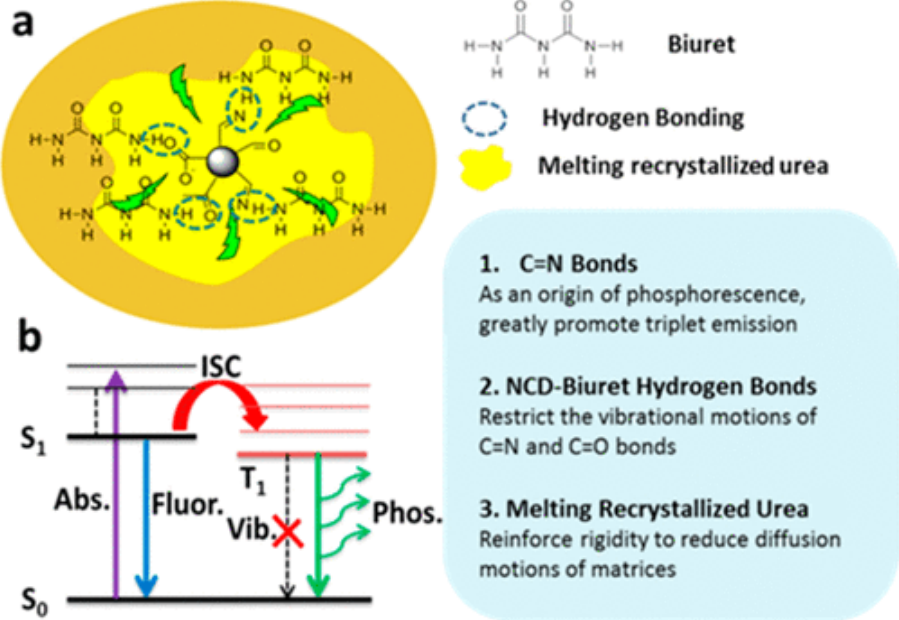
Figure 15. ( a ) N-doped CDs (NCDs in the figure) are embedded into melting recrystallized urea and biuret matrices. ( b ) Schematic illustration of possible energy structures of C=N bonds and phosphorescent emission processes. (Adapted from [124]; with the permission of the American Chemical Society).